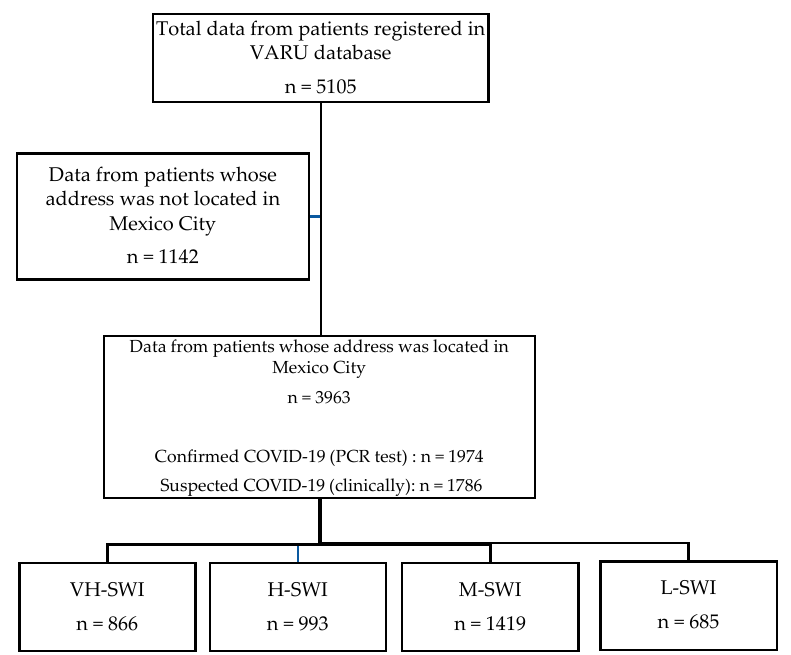
Figure 1. Total COVID-19 cases (n, %) and COVID-19 cases per 100,00 inhabitants in the 16 majors in Mexico City and by Social Welfare Index.